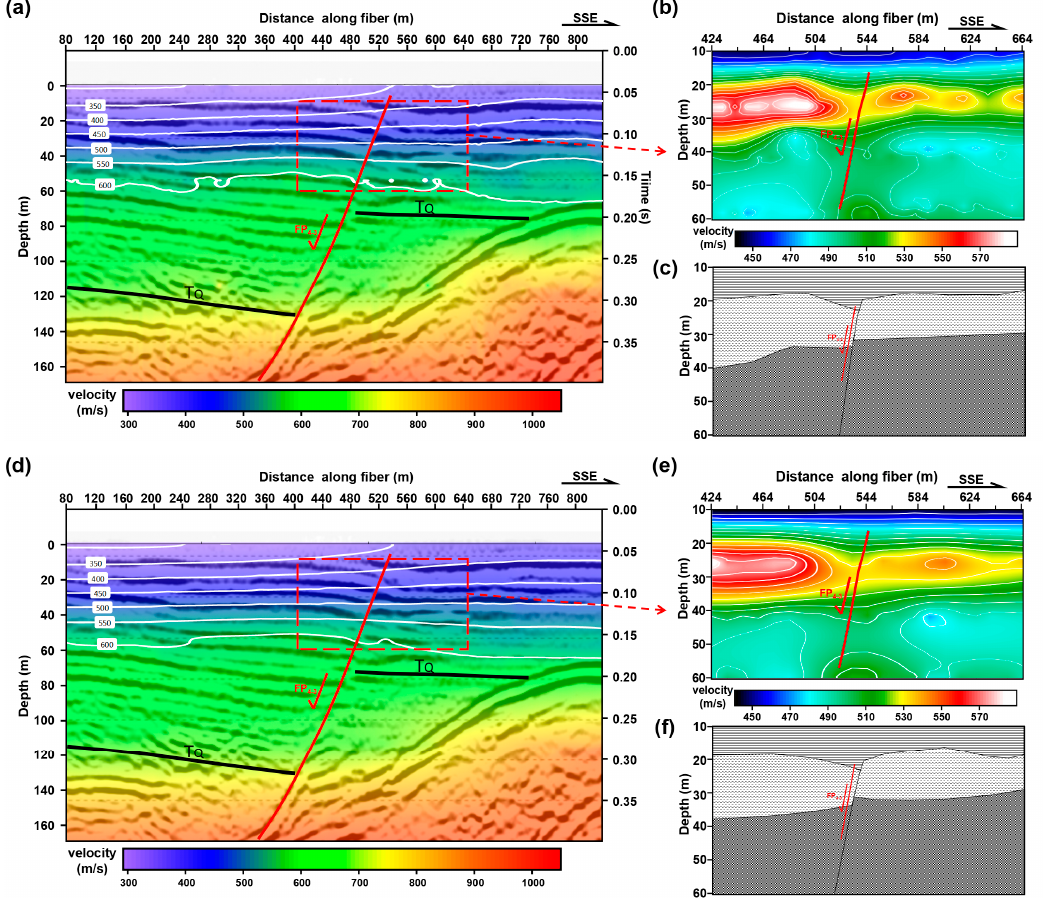
Figure 7. Microtremor Survey detection results. ( a ) and ( d ) are S-wave inversion profiles based on DAS data; these results use the dispersion curve information with the frequency of 1.8 Hz to 8 Hz and 2 Hz to 15 Hz, respectively. The wiggles in ( a ) and ( d ) are the active seismic survey detection results of line XL, shown in Figure 1b. ( c ) is a simple fault cartoon drawn according to the inversion results shown in ( b ). ( d ) and ( e ) are S-wave inversion profiles based on Z-component seismic data using the same method and parameters. ( f ) is a simple fault cartoon drawn according to the inversion results shown in ( e ); the color bars represent the velocity value of S-wave.